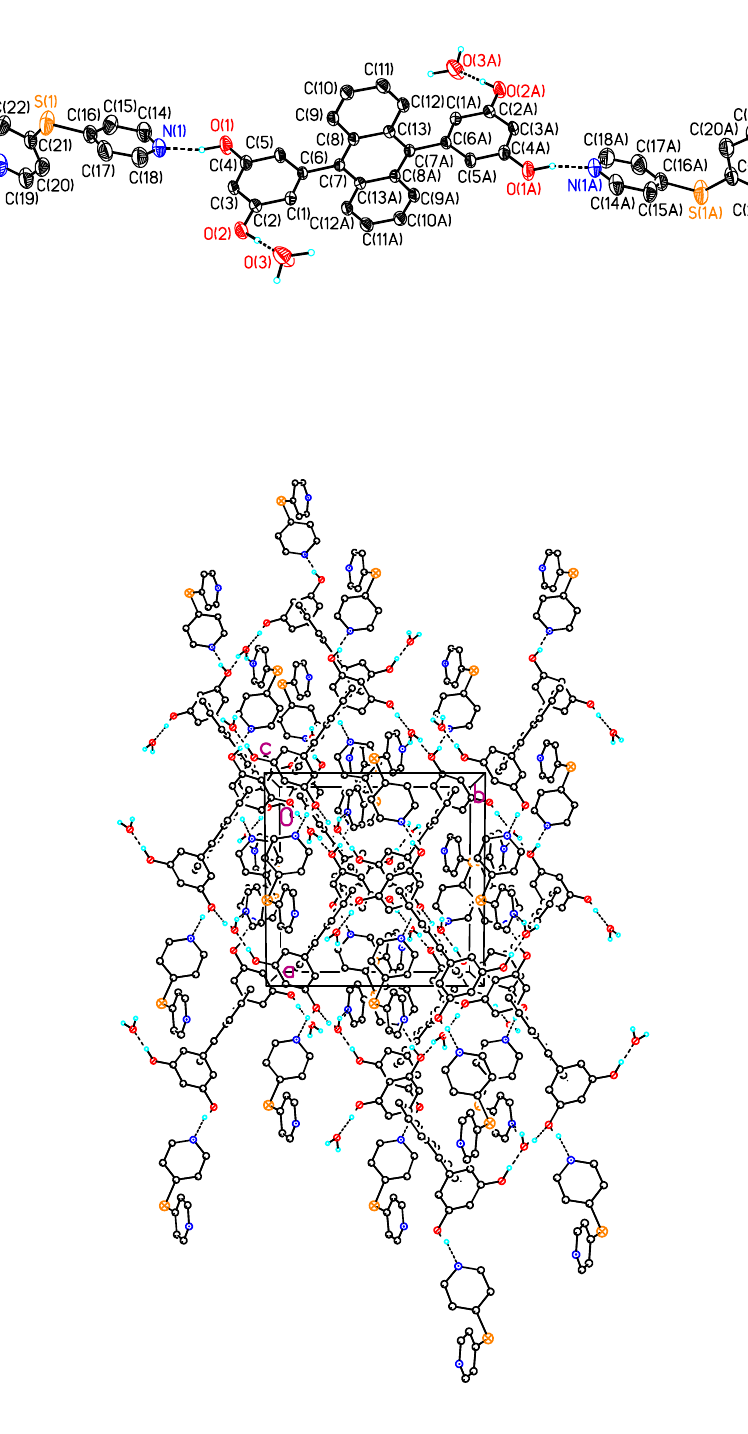
Figure 4 (a) The crystal structure of 4. Hydrogens were omitted for clarity. (b) The crystal-packing of 4 viewed down the c axis. Notice that 4 leads to a ladder structure, and two dipy-sul molecules were included in a